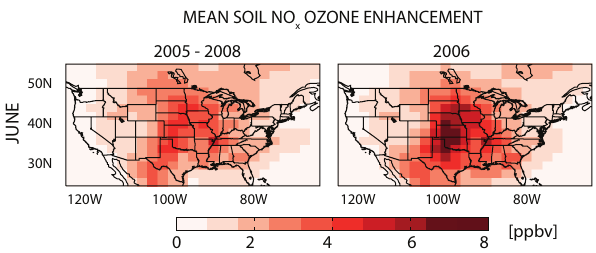
Fig. 6. June mean daily 8-h maximum ozone enhancement from soil NO x emissions for 2005 and 2007 (left) and 2006 (right) simulated using